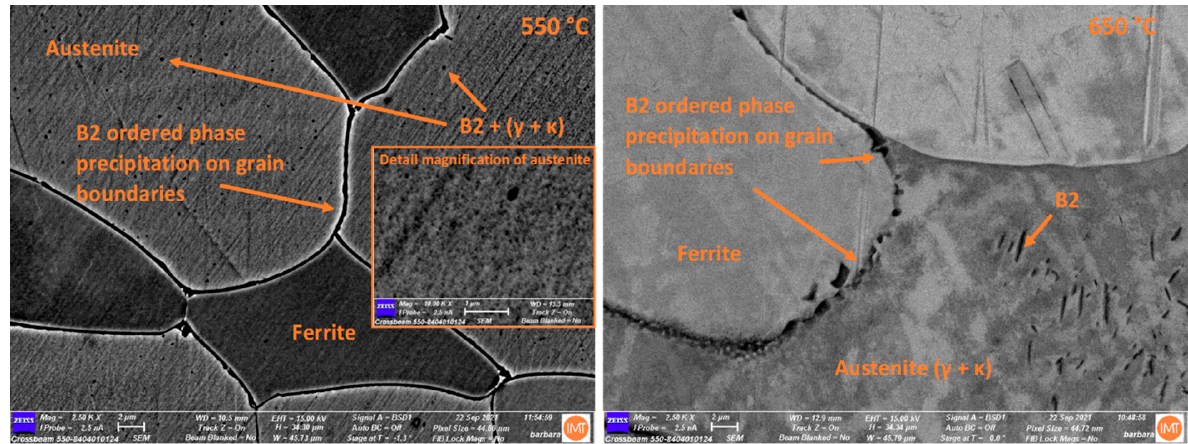
Figure 13. Backscattered electron images of the samples isothermally annealed at 550 and 650 °C.